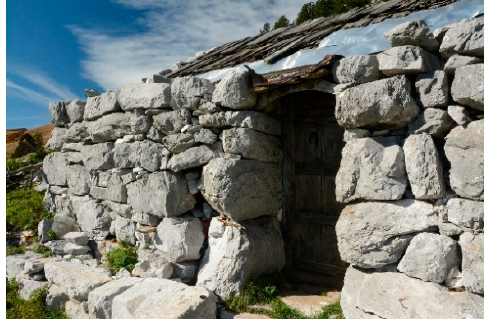
Figure 19. Construction of limestone, photo: I. Lakovi ć .